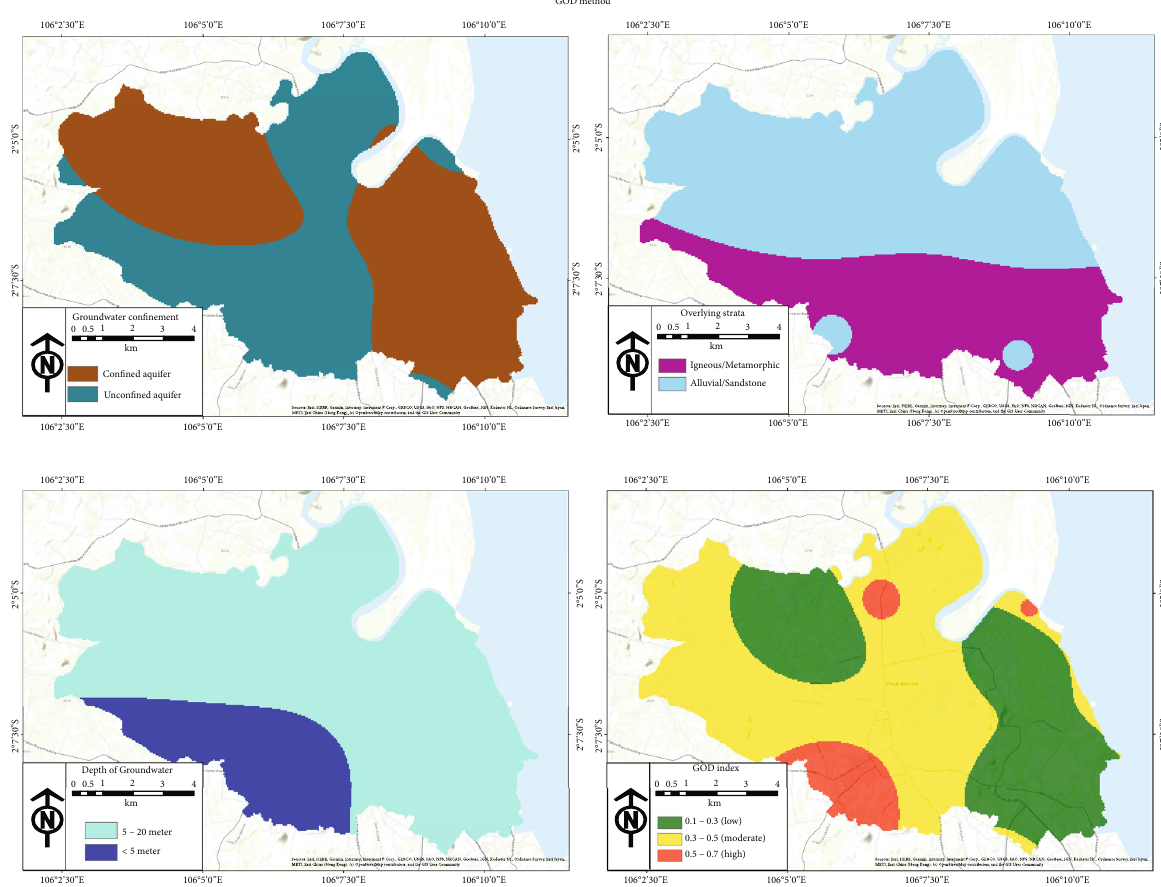
Figure 6: GOD method: (a) groundwater con fi nement; (b) overlying strata; (c) depth of groundwater; (d) GOD vulnerability